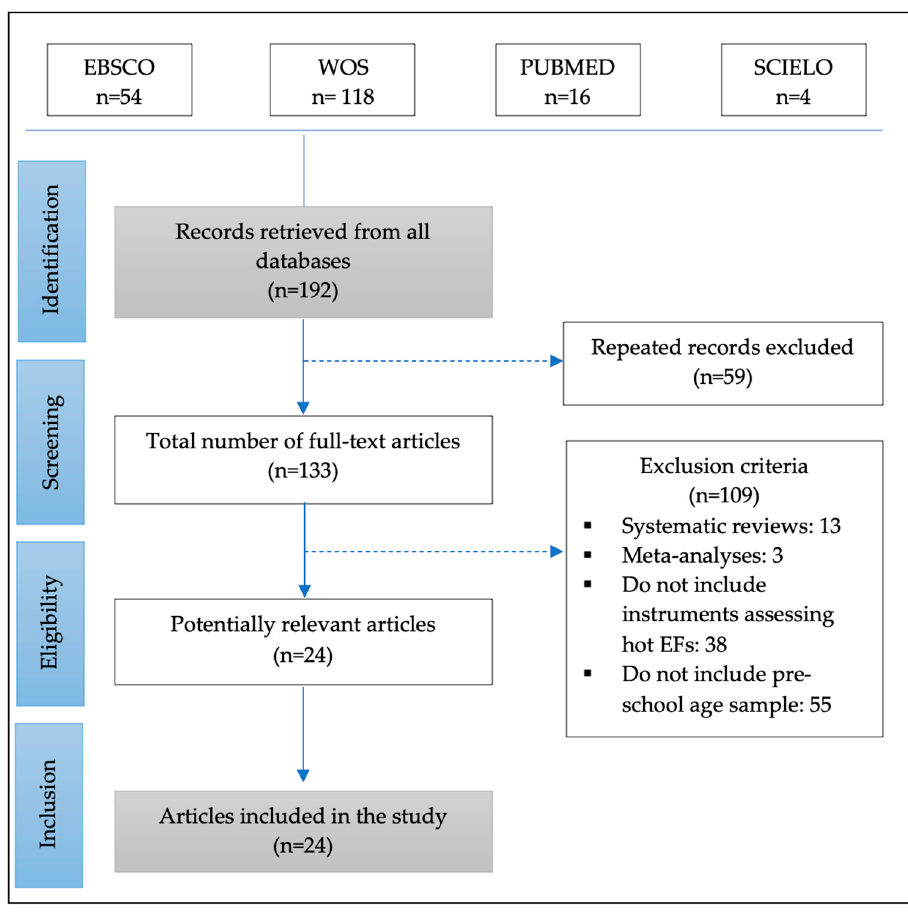
Figure 1. PRISMA Flowchart.